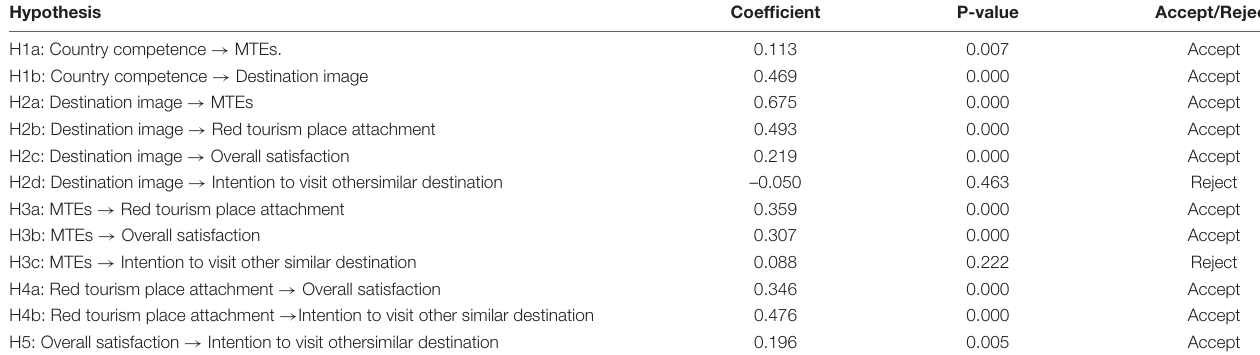
TABLE 4 | Summary of hypotheses’ test results.